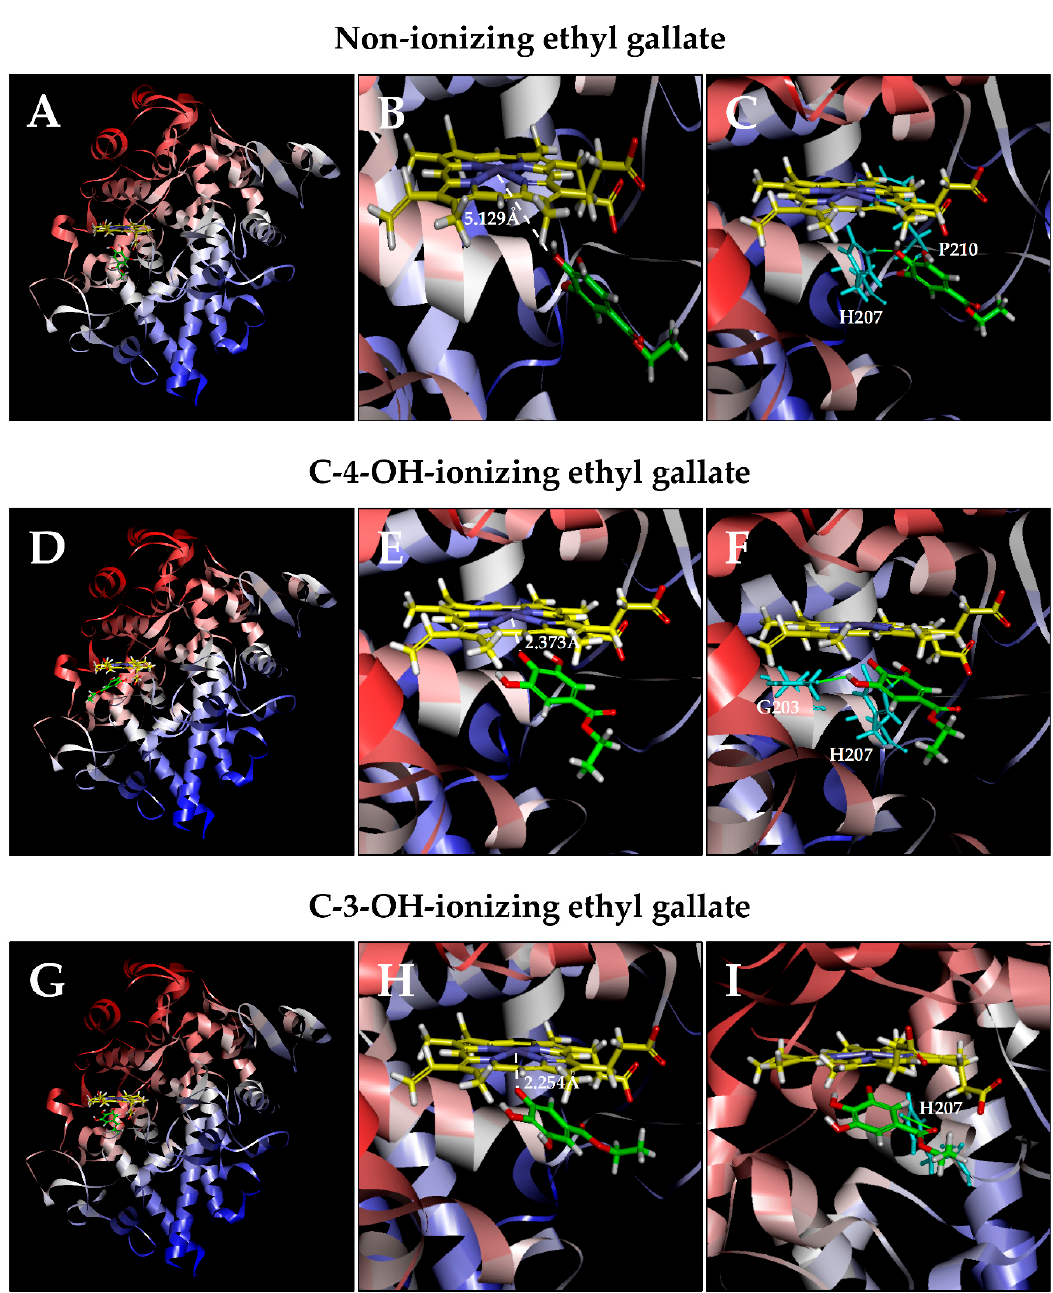
Figure 5. Molecular docking analysis of the binding interaction of ethyl gallate with the peroxidase active site of the COX-1 protein. Panels A , D , and G : The dominant docking result for non-ionizing ( A ), C-4-OH-ionizing ( D ), and C-3-OH-ionizing ( G ) ethyl gallate inside the peroxidase active site of COX-1. The protein structure is shown in a flat ribbon format. In P + Fe IV , carbon is colored in yellow, nitrogen in blue, oxygen in red, hydrogen in white, and iron in bice. In ethyl gallate, carbon is colored in green, oxygen in red, and hydrogen in white. Panels B , E , and H : The same structures as in panels A , D , and G with a white dashed line added to indicate the distance between Fe 4+ ion and O of one of the OH groups in ethyl gallate. Panels C , F , and I : Suggested potential hydrogen bonds (green lines) between the non-ionizing ( C ), C-4-OH-ionizing ( F ), or C-3-OH-ionizing ( I ) ethyl gallate and the amino acid residues (Gln203, His207, Phe210) in the peroxidase site. The amino acid residues are colored in light blue.